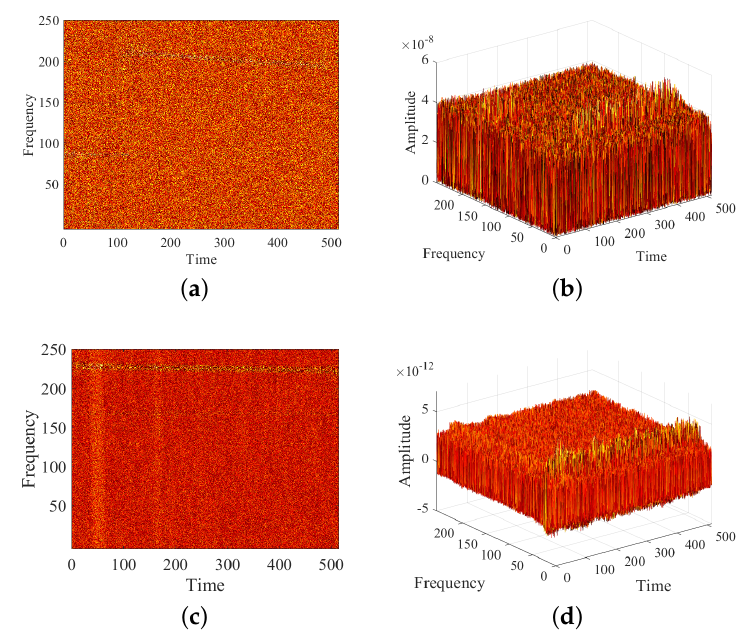
Figure 13. Heatmaps of the signals from DatasetIII and DatasetIV. ( a ) Two dimensional heatmap of signal from DatasetIII, ( b ) Three dimensional heatmap of signal from DatasetIII, ( c ) Two dimensional heatmap of signal from DatasetIV, ( d ) Three dimensional heatmap of signal from